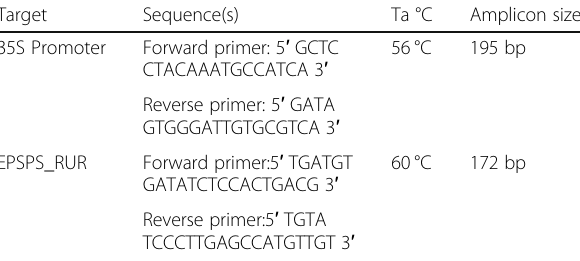
Table 1 Primer pairs used in the current